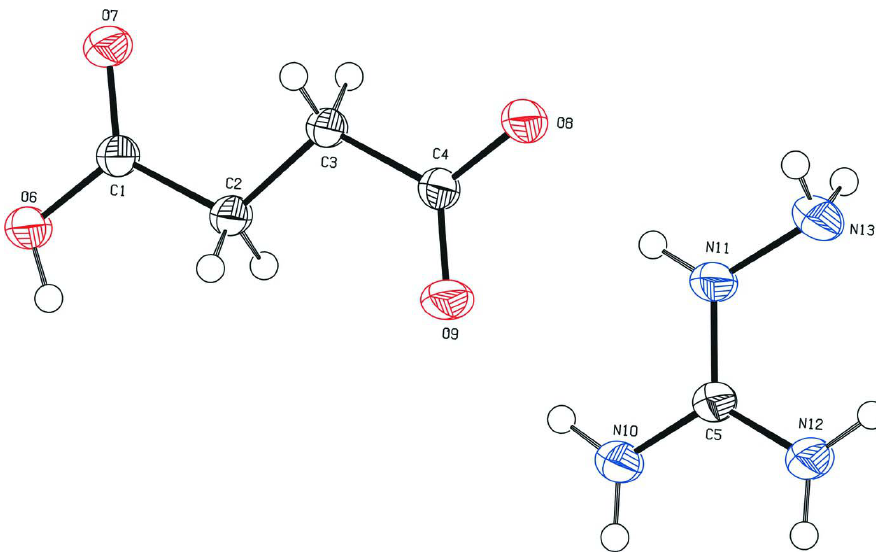
Figure 1 The molecular structure of title compound showing 50% probability displacement ellipsoids.